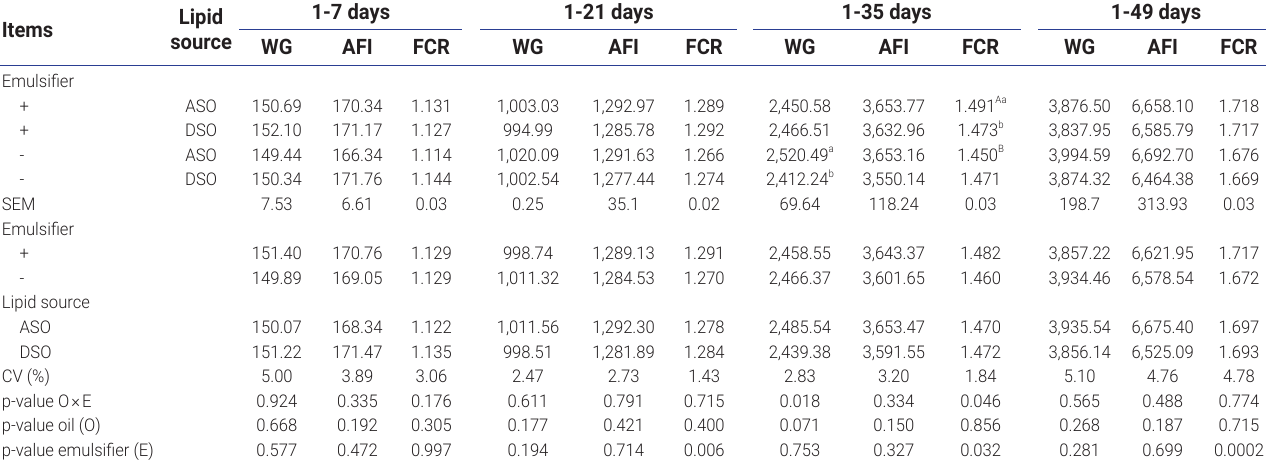
Table 4. Growth performance of broilers fed diets containing different lipid sources, with or without emulsifier 1-7 days 1-21 days Lipid Items source